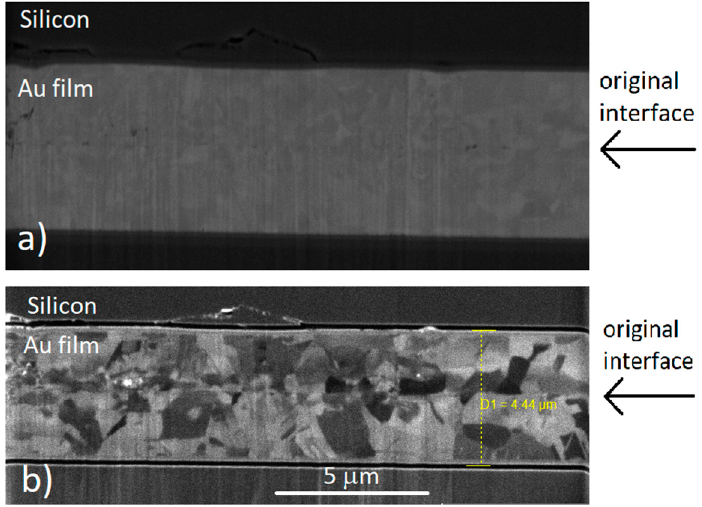
Figure 7. Cross-sectional ( a ) electron beam and ( b ) ion beam images of bonded 2 µ m samples.